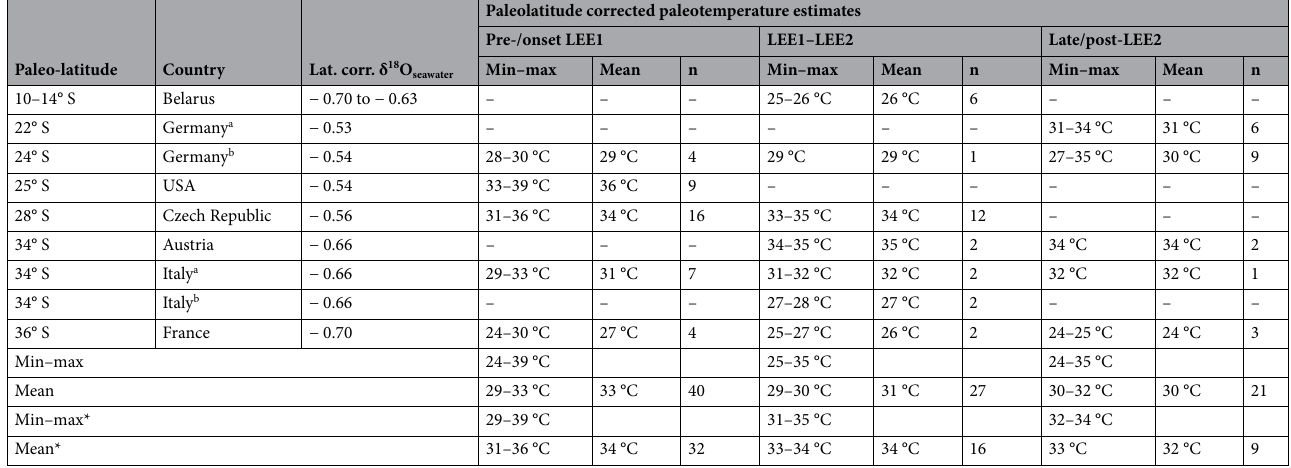
Table 2. Paleolatitude corrected regional paleotemperature including the latitude correction values for δ 18 O seawater and mean values calculated for each paleolatitude/country and biozone. Pre-/onset LEE1 = kockelianus Biozone; LEE1–LEE2 = ensensis Biozone; late/post-LEE2 = hemiansatus Biozone; Germany: a = Blauer Bruch, b = Eifel; Italy: a = ZMB section, b = Val di Collina quarry; min–max* and mean* calculated excluding shallow marine localities: Belarus, Germany b , Italy b and France. Lat. corr. = latitude correction. Overall mean SST of the Carnic Alps (summarizing localities in Austria and Italy a ) are 33 °C for the ensensis and hemiansatus